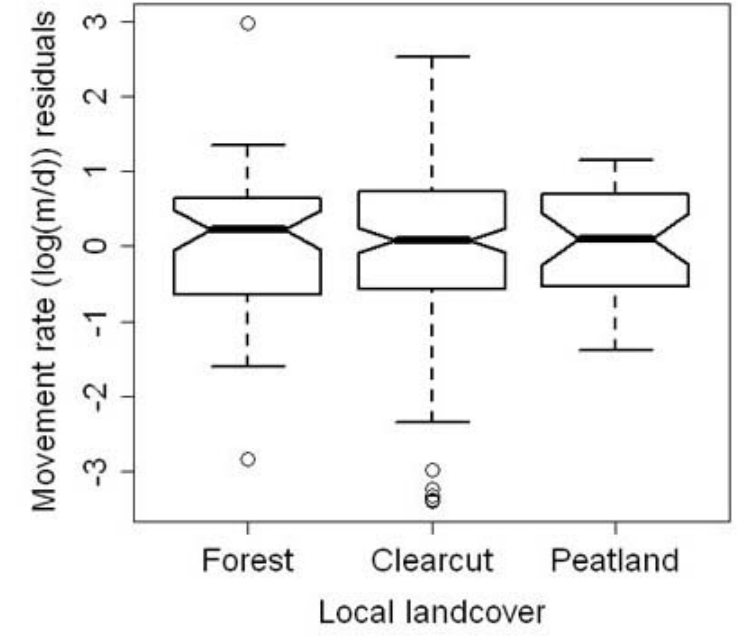
Fig. 5. Box plots illustrating differences in movement rate residuals for Blackpoll Warblers moving away from local areas composed of forest, clearcut, and peatland land-cover types. The horizontal bar in the middle of each box (between the notches) represents the median residual value for each category. The bottom and top boxes below and above the median line represent the 25th and 75th percentiles of the data, respectively. The whiskers illustrate the minimum and maximum values of the residuals not considered to be outliers. The circles located outside the whiskers of the clearcut box represent potential outlying